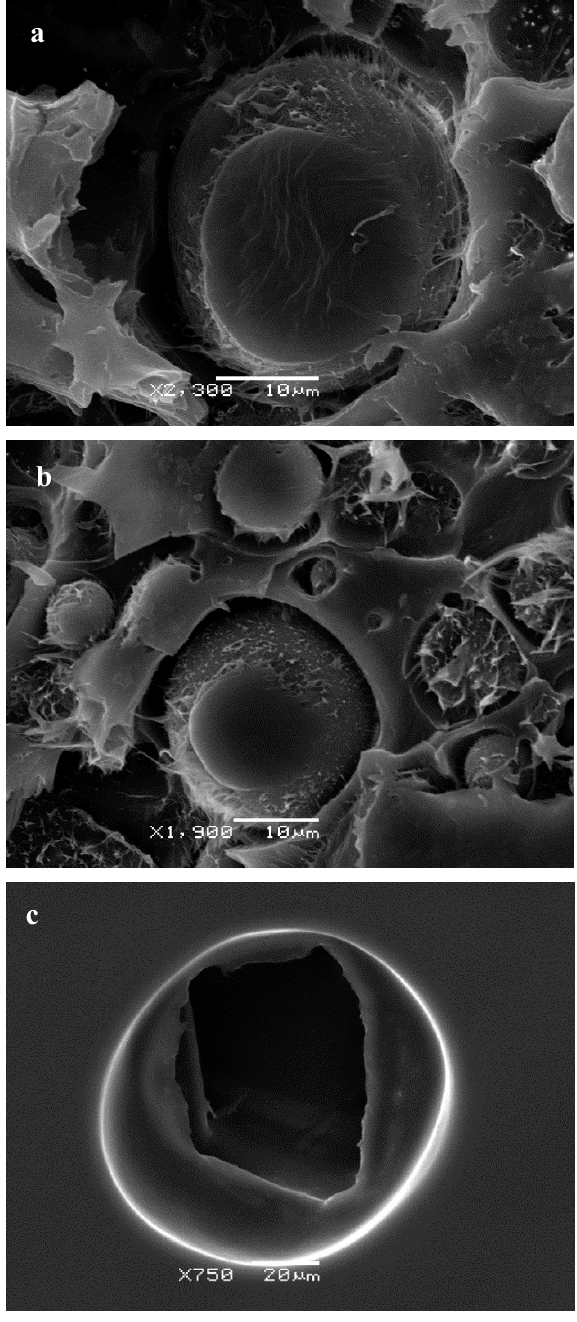
Figure 3. Representative SEM micrographs of cross-section RSV-loaded microcapsules prepared with different concentrations of poly- ε -caprolactone: ( a ) 2.91% PCL; ( b ) 1.5% PCL; ( c ) 0.08% PCL.